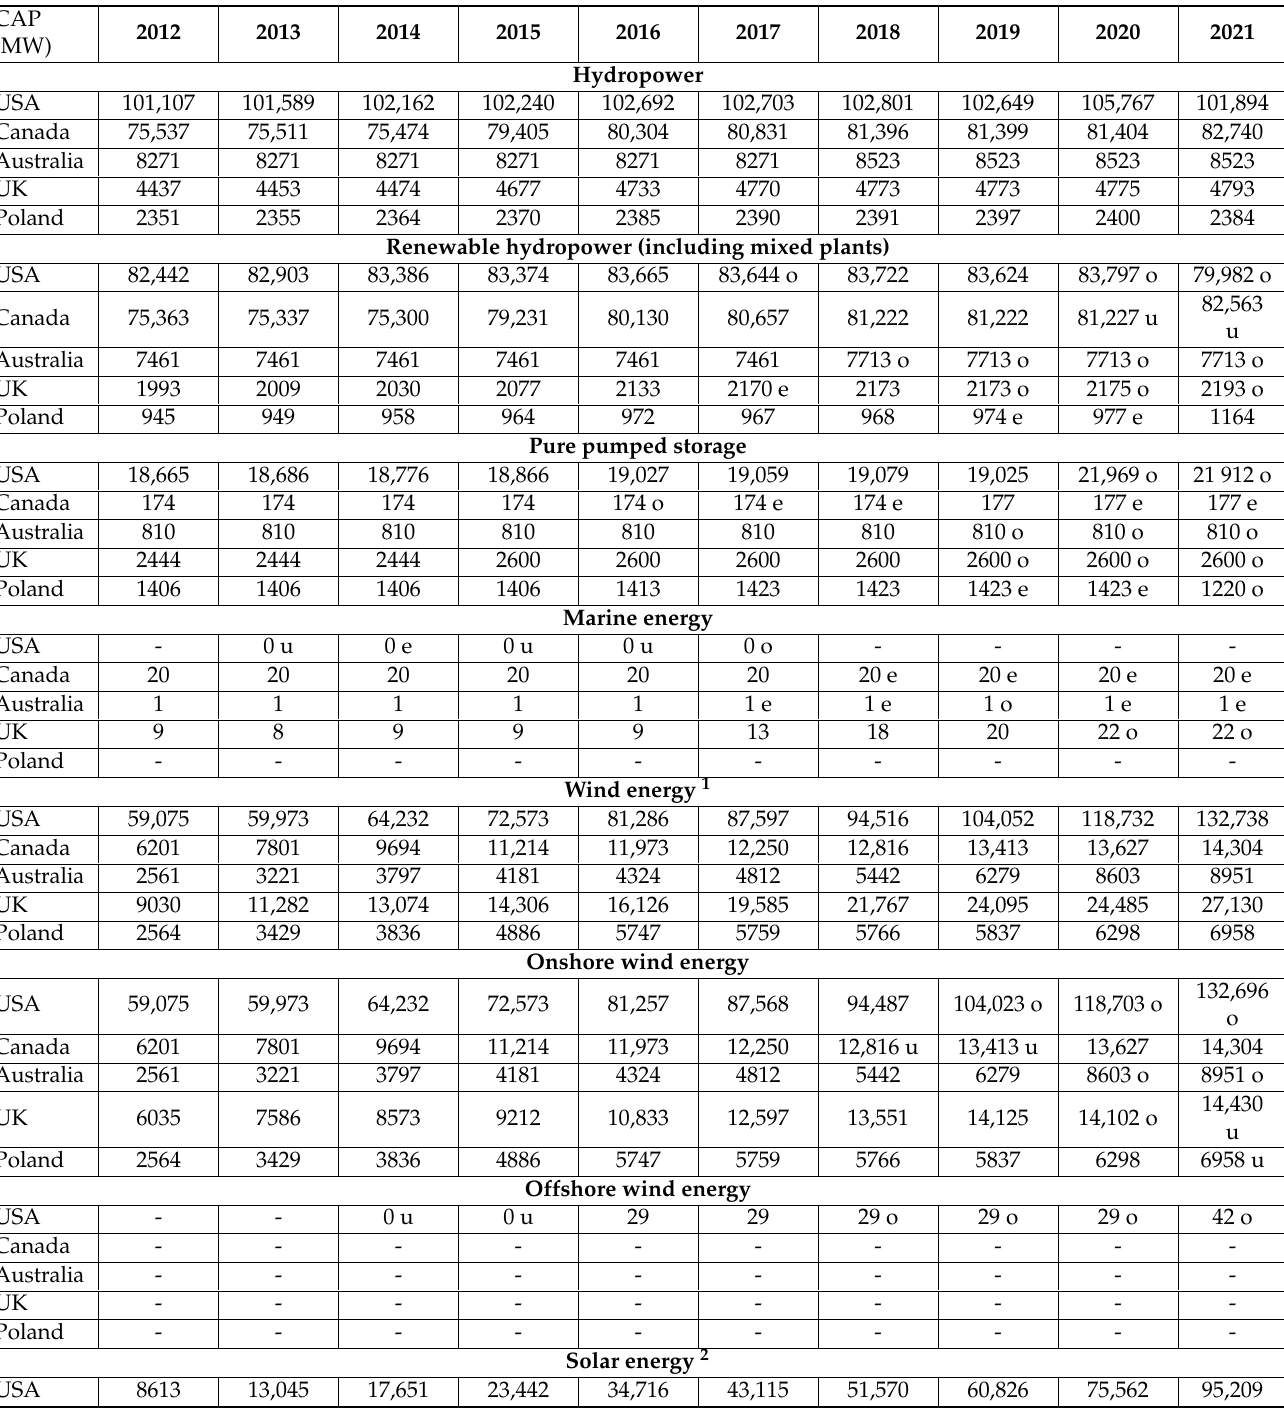
Table A1. Level of green energy production in selected countries-by